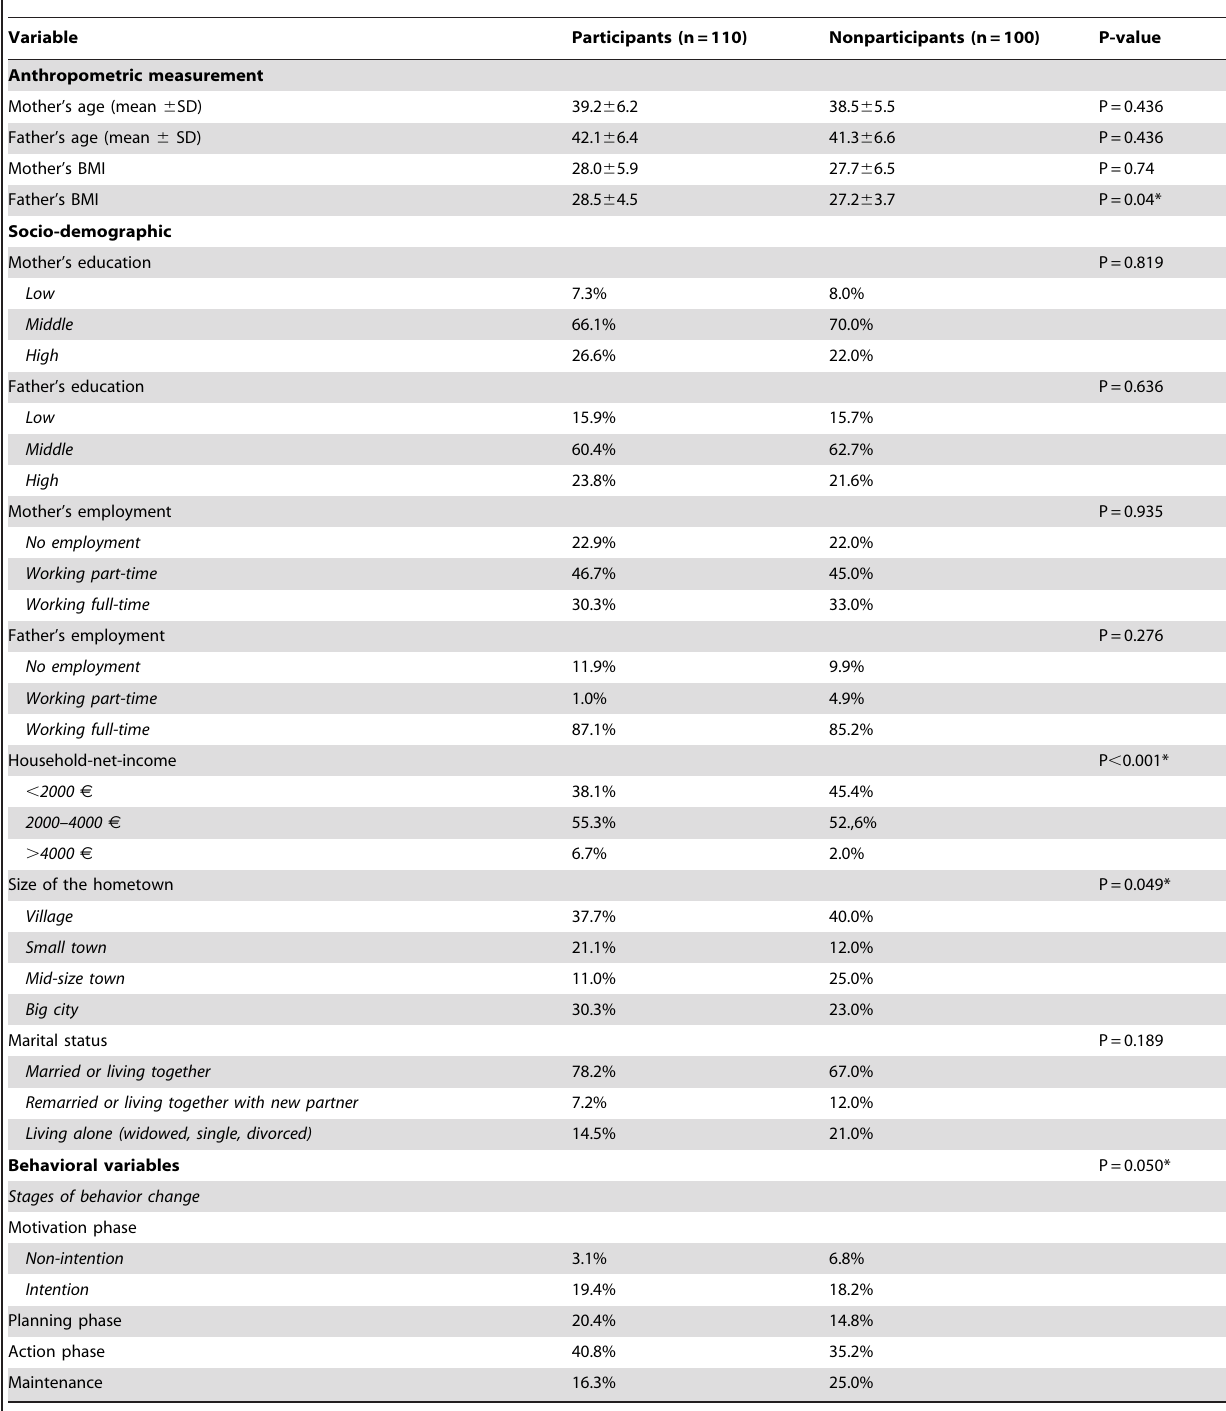
Table 2. Baseline characteristics of parents of participating and nonparticipating